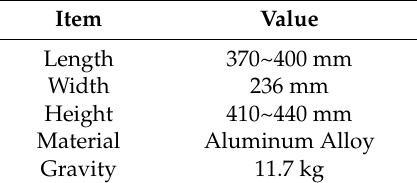
Table 1. The parameters of the robot.